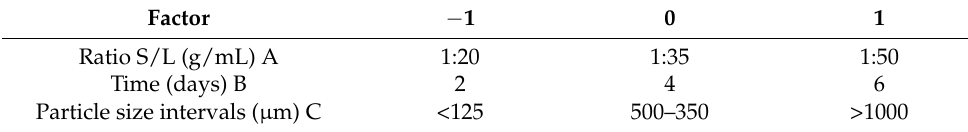
Figure 6. Extraction yield of resveratrol after 7 extractions on the same material.